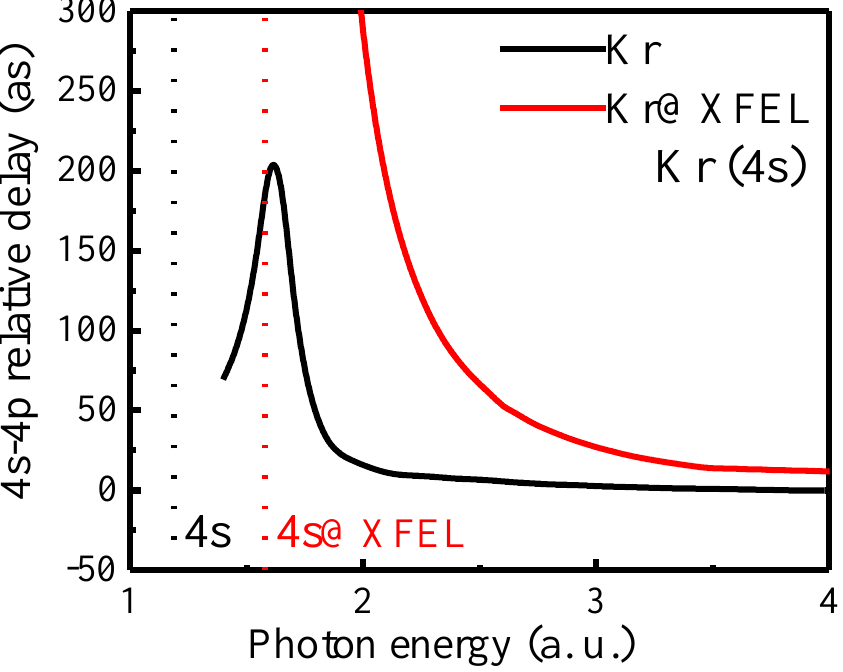
Figure 14. The time delay difference of 4s and 4p subshell (τ(4s)-τ(4p)) of Kr (black) and Kr@XFEL (red) in the RRPA calculation. Vertical lines show the 4s subshell threshold for Kr (black) and Kr@XFEl (red).